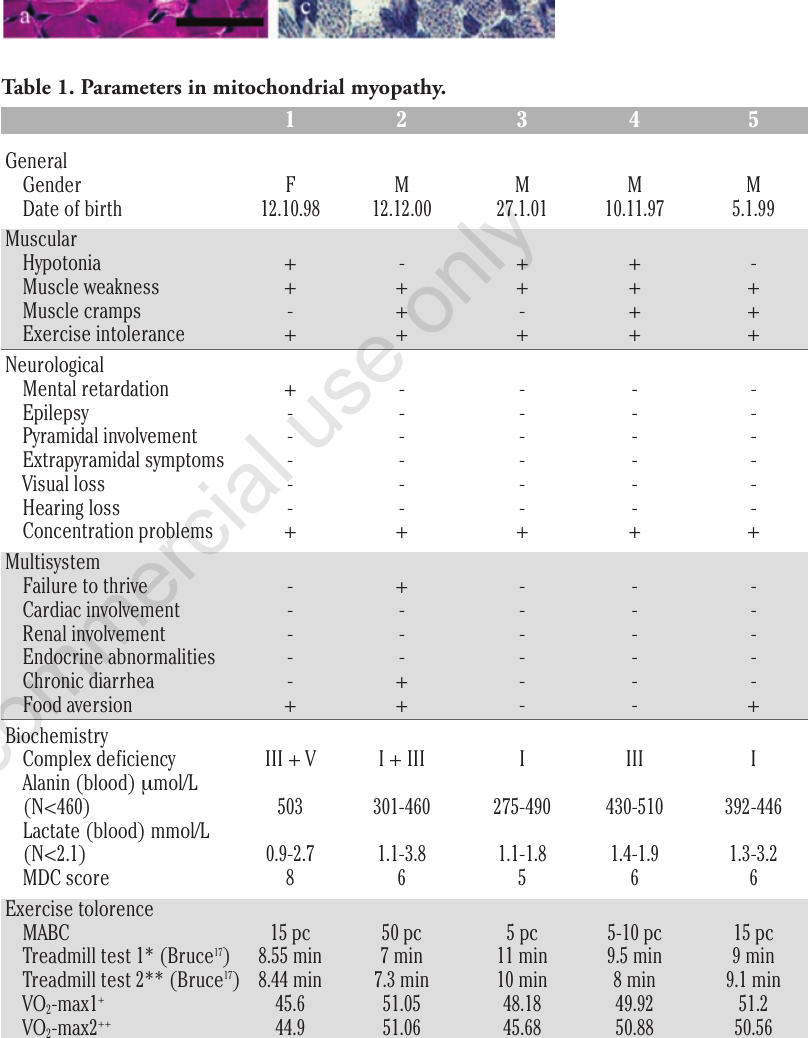
Figure 1. (a) Hematoxylin and eosin, (b) ATPase, and (c) NADH staining in the muscle biopsy of patient 1. A mild fiber type variation (type 1 fibers are smaller than type 2 fibers) can be observed. No complex deficiency was noted histochemically.